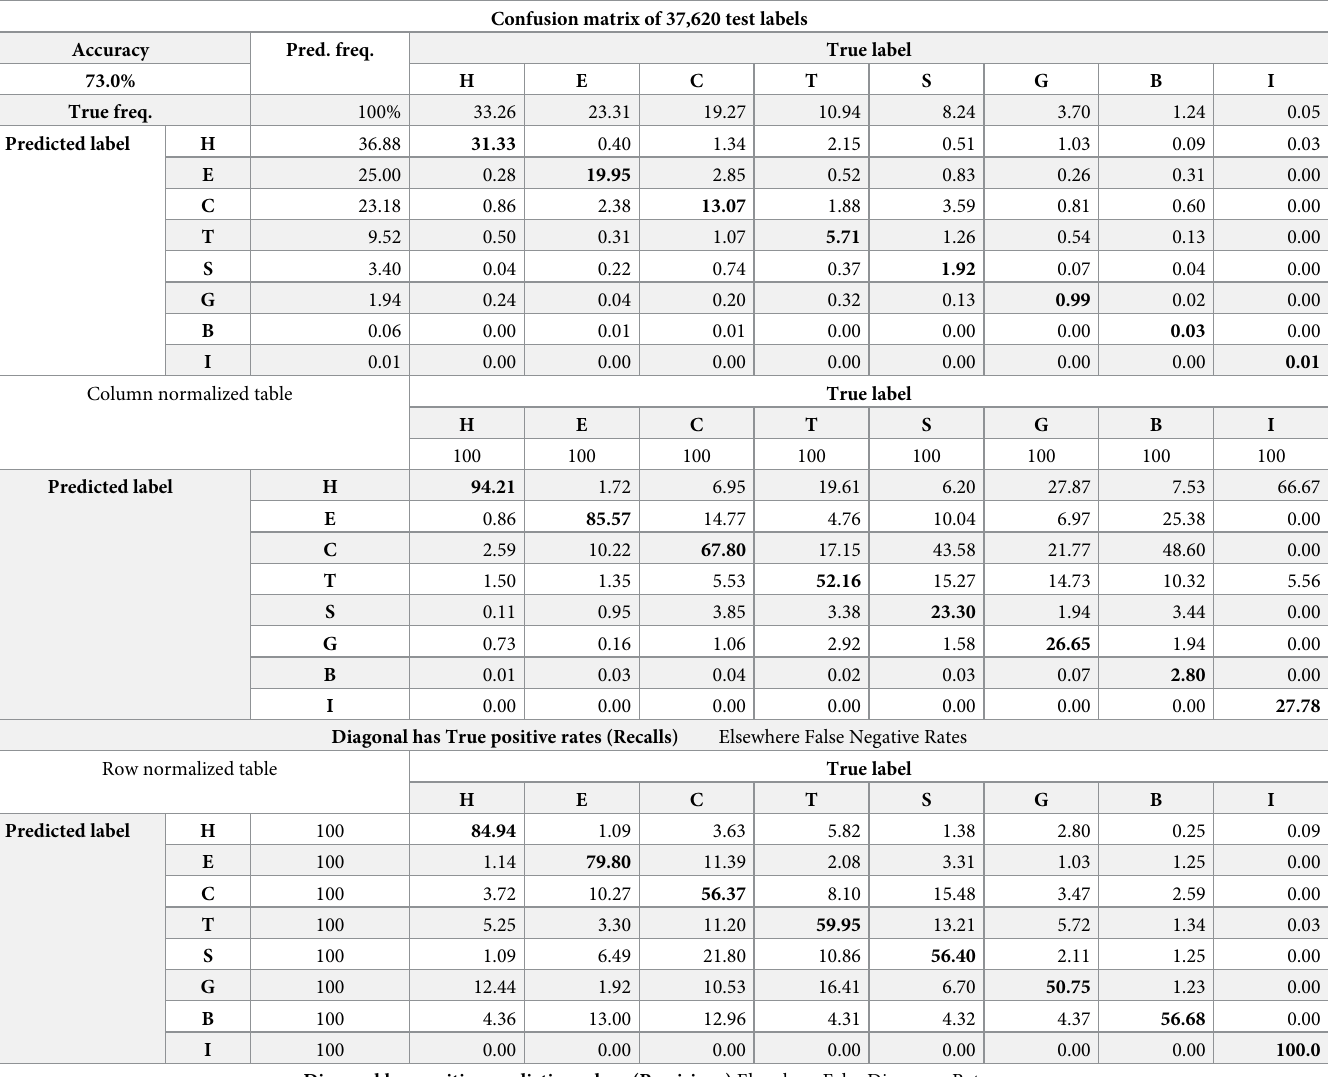
Table 2. Confusion matrices for 8-label alphabet: H , E , C , T , S , G , B , and I . (1) Confusion matrix, (2) true positive rates (recalls) and false negative rates and (3) positive predictive values (precisions) and false discovery rates of SecNet on Test2018 test set. Confusion matrix of 37,620 test labels Accuracy Pred. freq. True freq. Predicted label